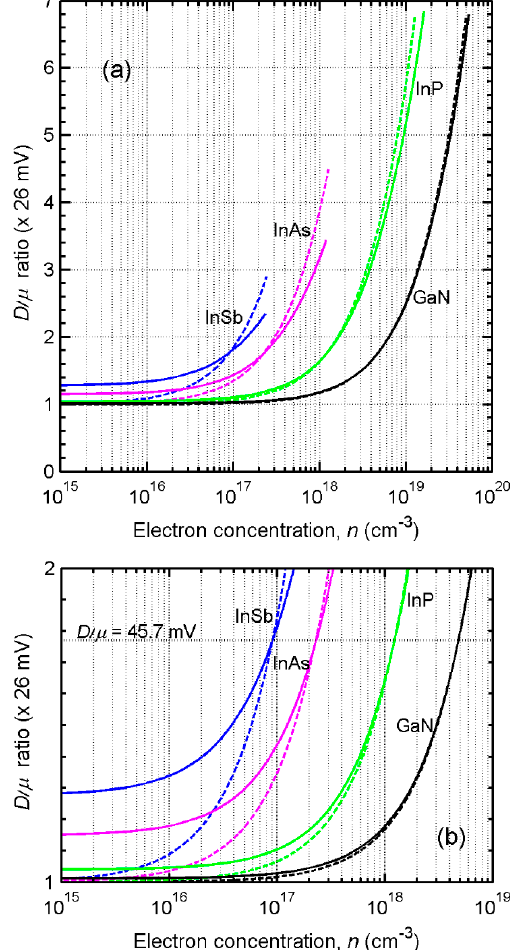
Figure 6. The values of the D / μ ratios (solid curves), shown in Figure 5, are compared with those of the D / μ ratios (dashed curves) calculated with the parabolic band approximation ( β = 0) for the same temperature. The plot ( b ) is an enlarged detailed view of the plot ( a ) for the values in the nondegenerate condition.